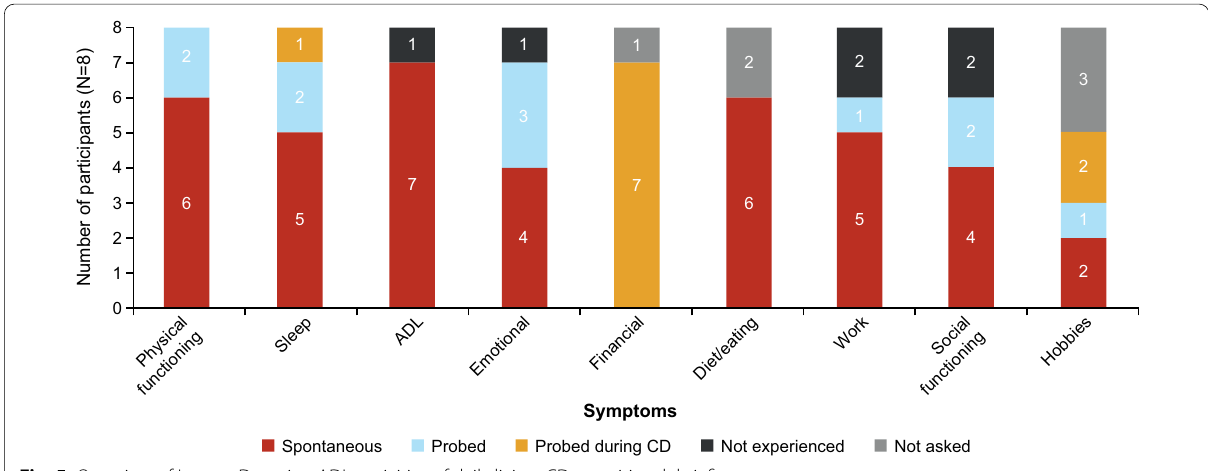
Fig. 5 Overview of Impact Domains. ADL, activities of daily living; CD, cognitive